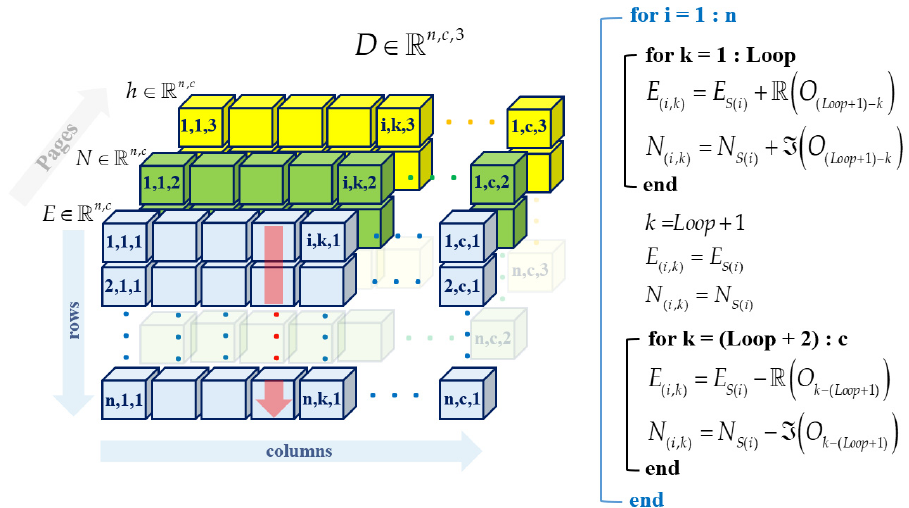
12 of 26 Figure 6. Schematic drawing of planimetric grid node generation. The planimetric coordinates of the nodes are contained in a 3D array , ,3 nc D ∈ (cid:0) , char- acterized by three overlapping 2D arrays with n rows (n equal to the total number of ver- tices S) and c columns ( ) 2